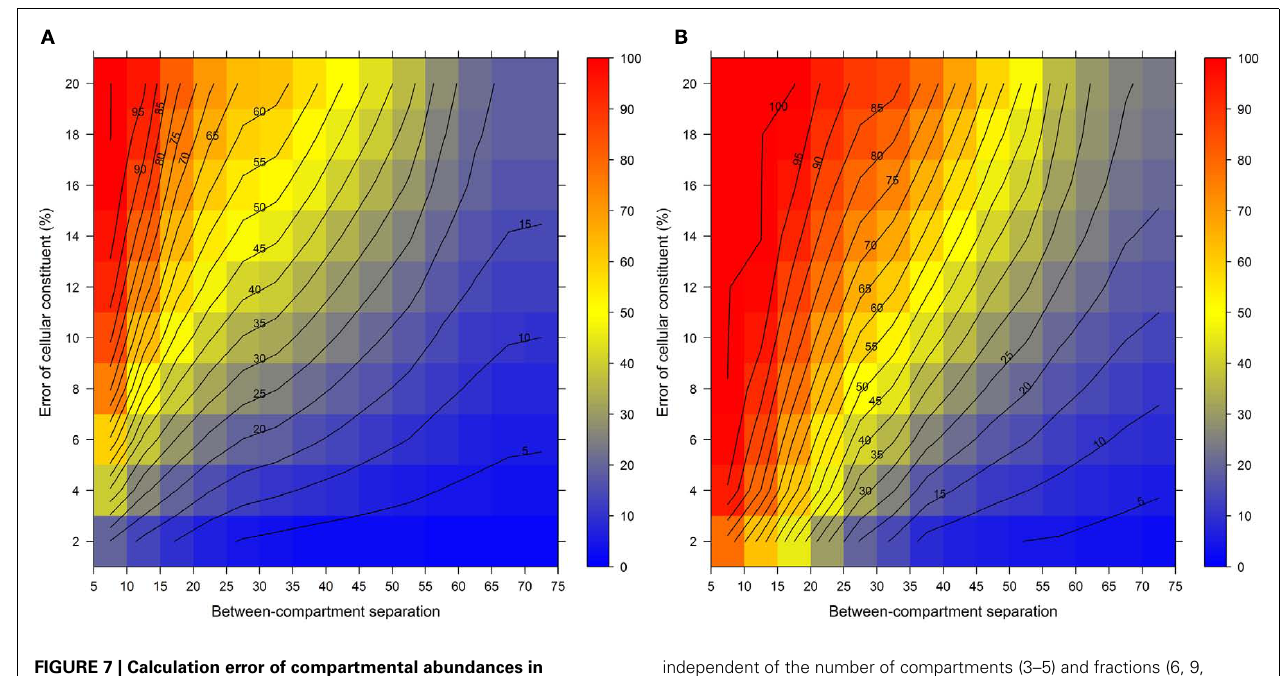
FIGURE 7 | Calculation error of compartmental abundances in dependence of the between-compartment separation and the metabolite error based on simulated data. The estimated error, the discrepancies to the estimates of the error-free distributions, are depicted as (A) mean–average and (B) 99th percentile for each combination of between-compartment separation and metabolite error